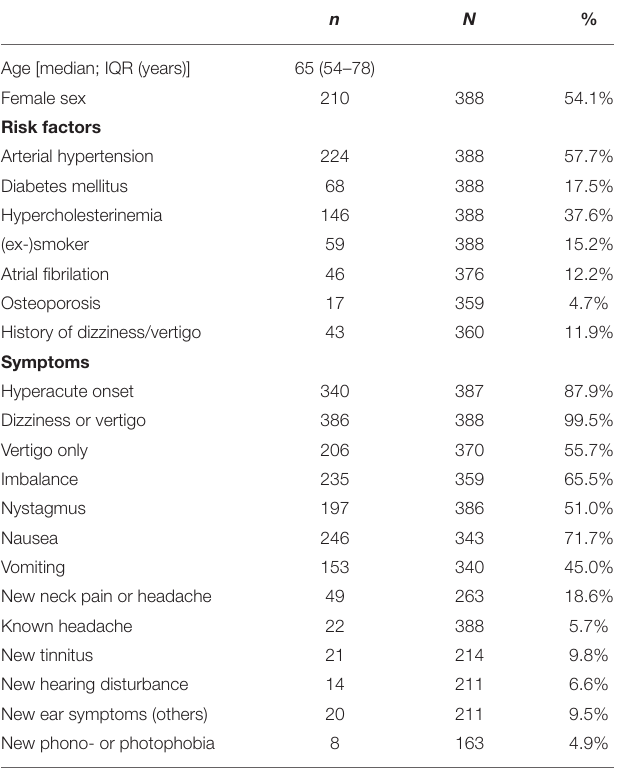
TABLE 2 | Baseline characteristics of all cases with an acute leading symptom of dizziness, vertigo, or imbalance of unknown cause (ADVIUC). n N